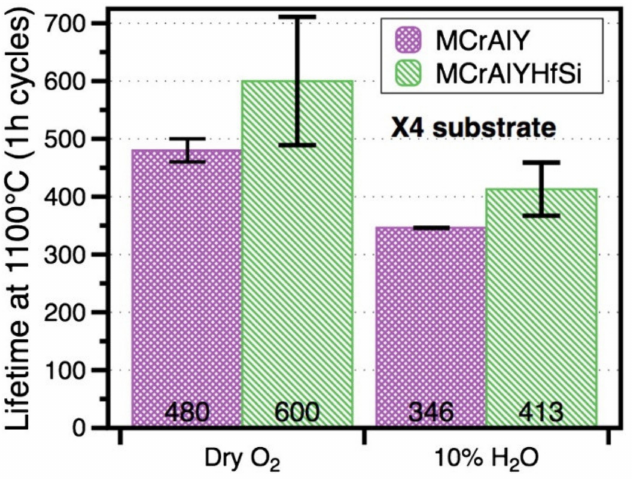
Figure 3. Comparison of the effects of the environment (dry oxygen or air + 10 vol.% H 2 O) and high-velocity oxy-fuel spray processed (HVOF) bond coat composition on average air plasma sprayed